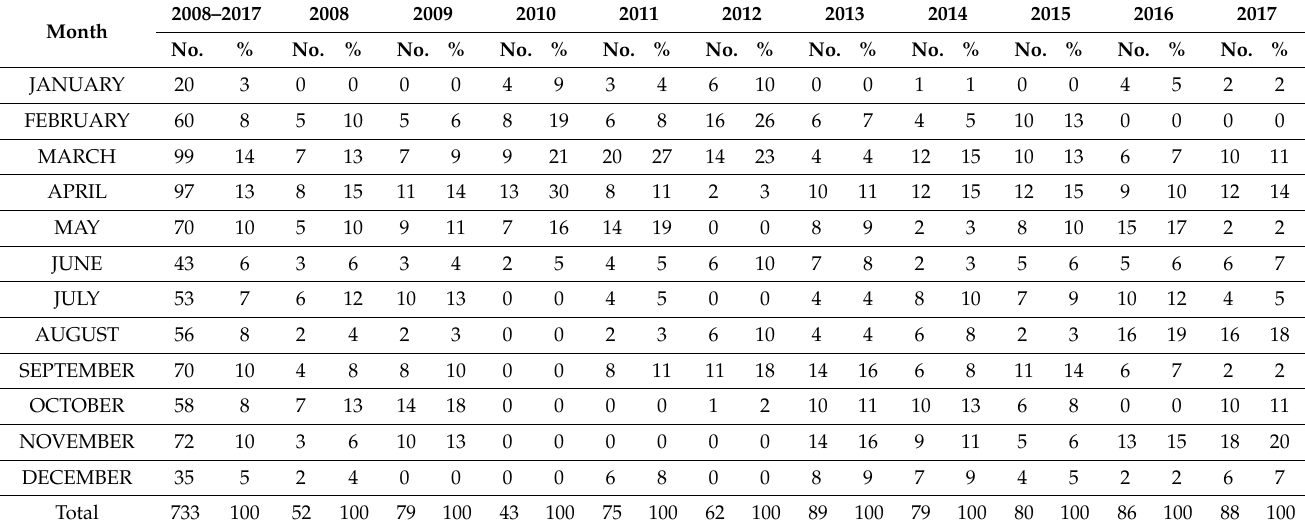
Table 2. Distribution of sampling by month. Period 2008–2017 (mean values for the whole period are